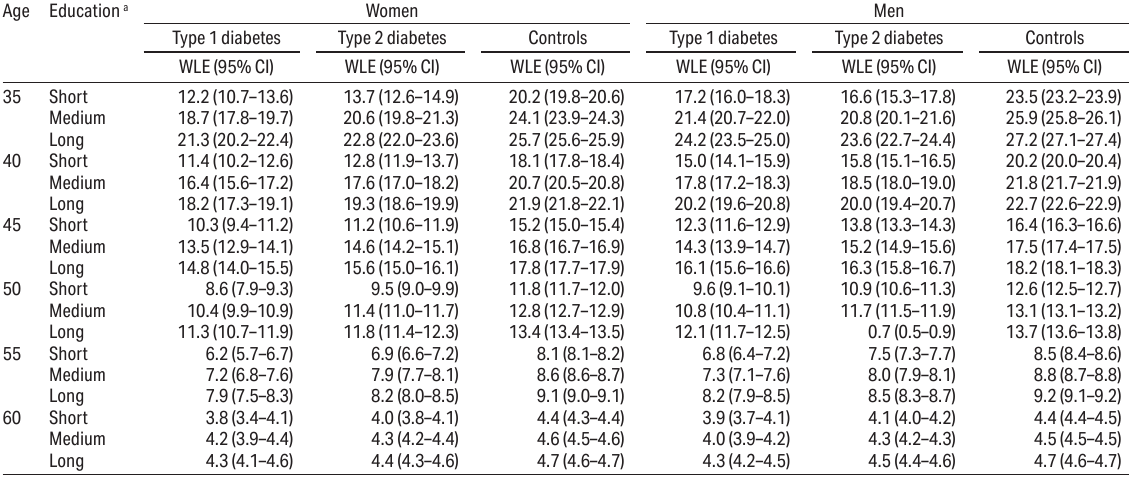
Table 2 a. Working life expectancies (WLE) in years and 95% confidence intervals (CI) of cohabitant men and women with type 1 and type 2 diabetes and controls by age, and education.